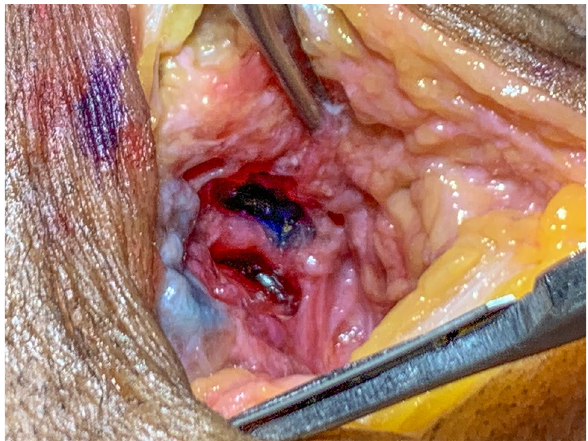
Figure 2. Coloured fluids located in the upper and lower compartments of the TMJ.